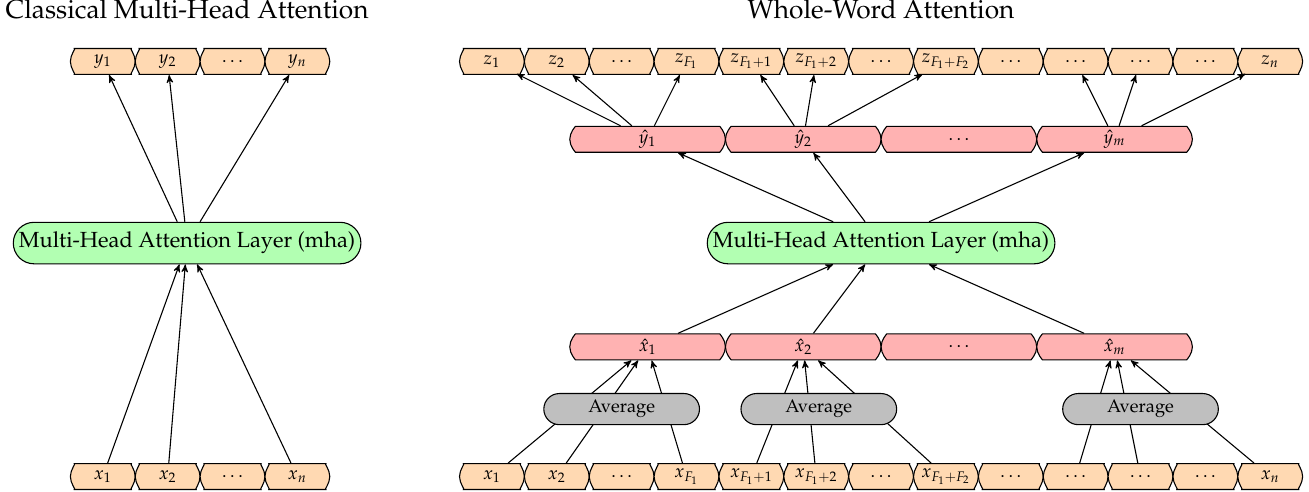
Figure 2. Left : Multi-Head Attention. Right : Our concept of Whole-Word Attention, where classical Multi-Head Attention is applied on words instead of tokens. Orange: Members of sequences, whose length is the number of tokens n . Red: Members of sequences, whose length is the number of words m . For a better overview, we define F j : = as the number of tokens the j ’th word consists